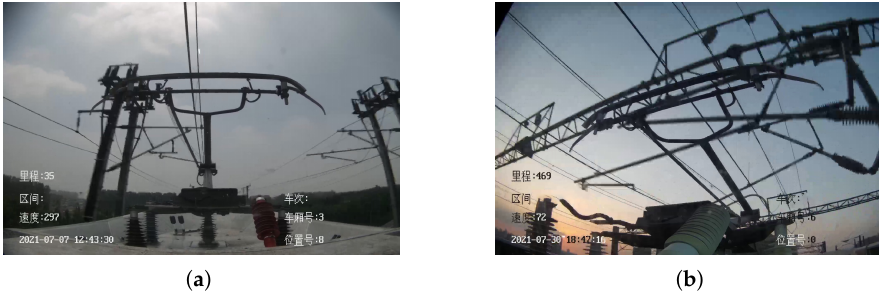
Figure 10. Catenary support device affects pantograph detection. ( a ) HSR-A. ( b ) HSR-B.